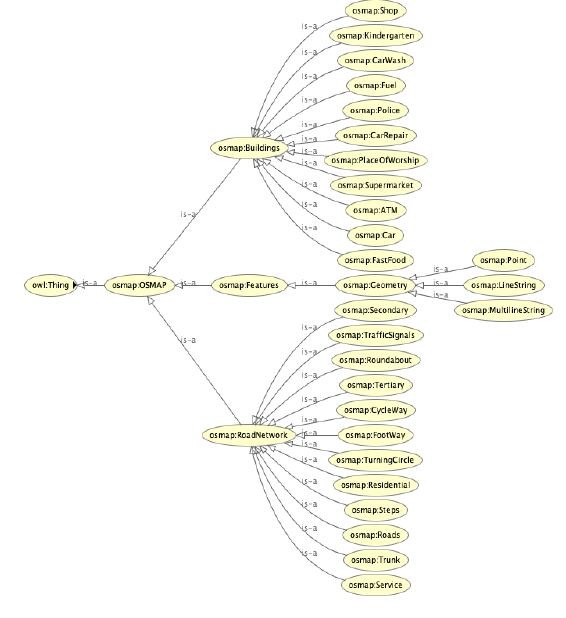
Figure 4. Representation of the OSMAP ontology.